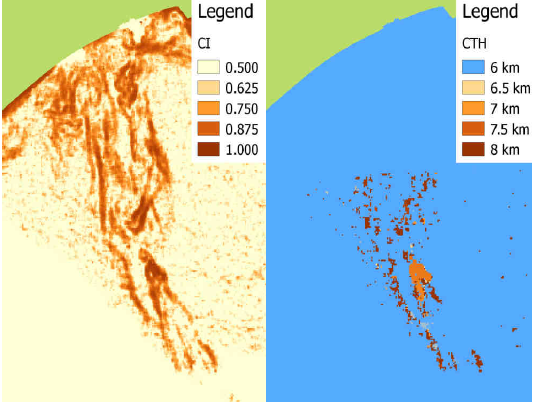
Figure 8. Correlation index over the sea on the left and CTH for pixels that passed the internal accuracy control on the right. The extent of this image is shown with the red rectangle on fig.